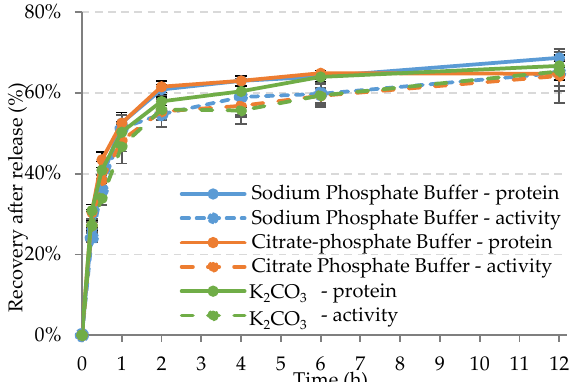
Figure 5. Kinetics release of cutinase from LDH/Cut-2/1 over 12 h in different solutions.